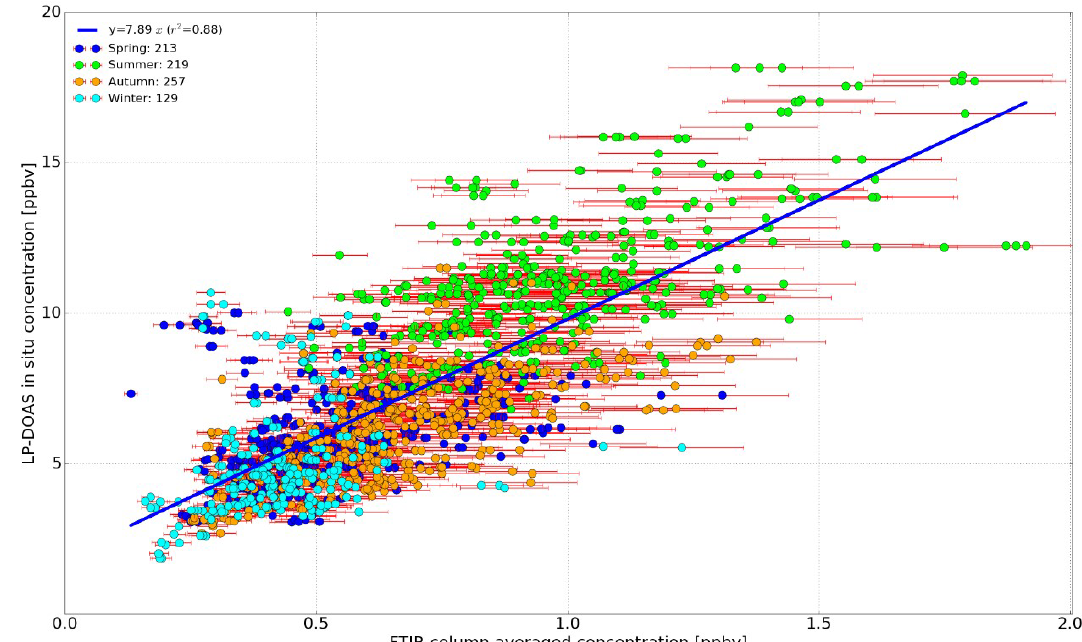
Figure 3. Correlation plots of FTIR X HCHO measurements against LP-DOAS ground-level HCHO measurements. The blue lines are linear- fitted curves of respective scatter points. All concurrent data pairs were grouped by season. The number of data pairs within each season was also